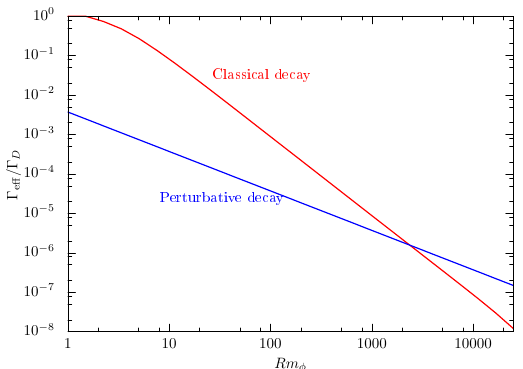
Figure 7 . The ratio of the effective decay rate of the fermion on the string ring to that of the free fermion Γ D in eq. (2.15). The center of the ring is at the origin and its radius is R . Here we set m ψ = m φ and the initial conditions of the particle are ~r = ( R, 0) and ~p = (0 , m φ ) . We approximate h f ( ~r ) = h ( || ~r | − R | ) where h is the profile in eq. (2.9). For a comparison, we also show the